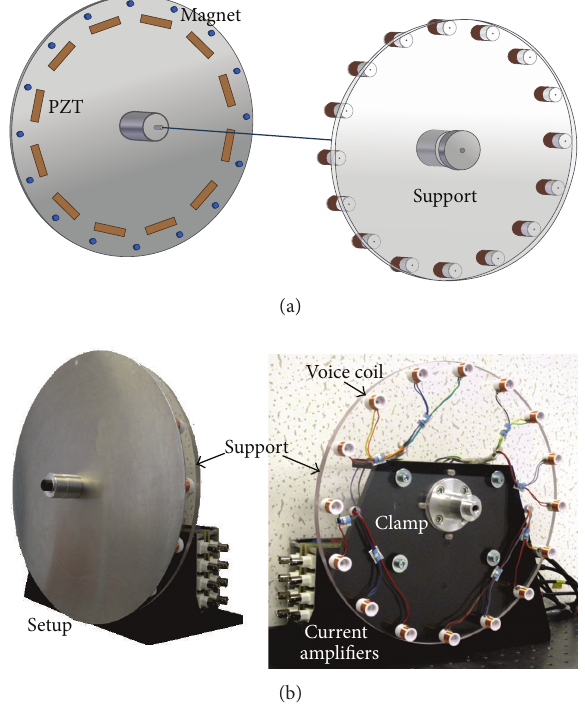
Figure 6: Circular plate clamped at the center equipped with 12 PZT patches. (a) CAD view ofthe setup, (b)experimental setup including 16 noncontact voice coil